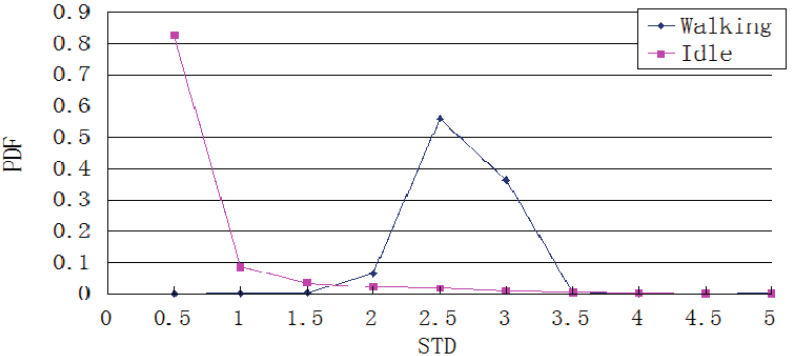
Figure 10. Distribution of the standard deviation of the overall acceleration in stationary and walking states.